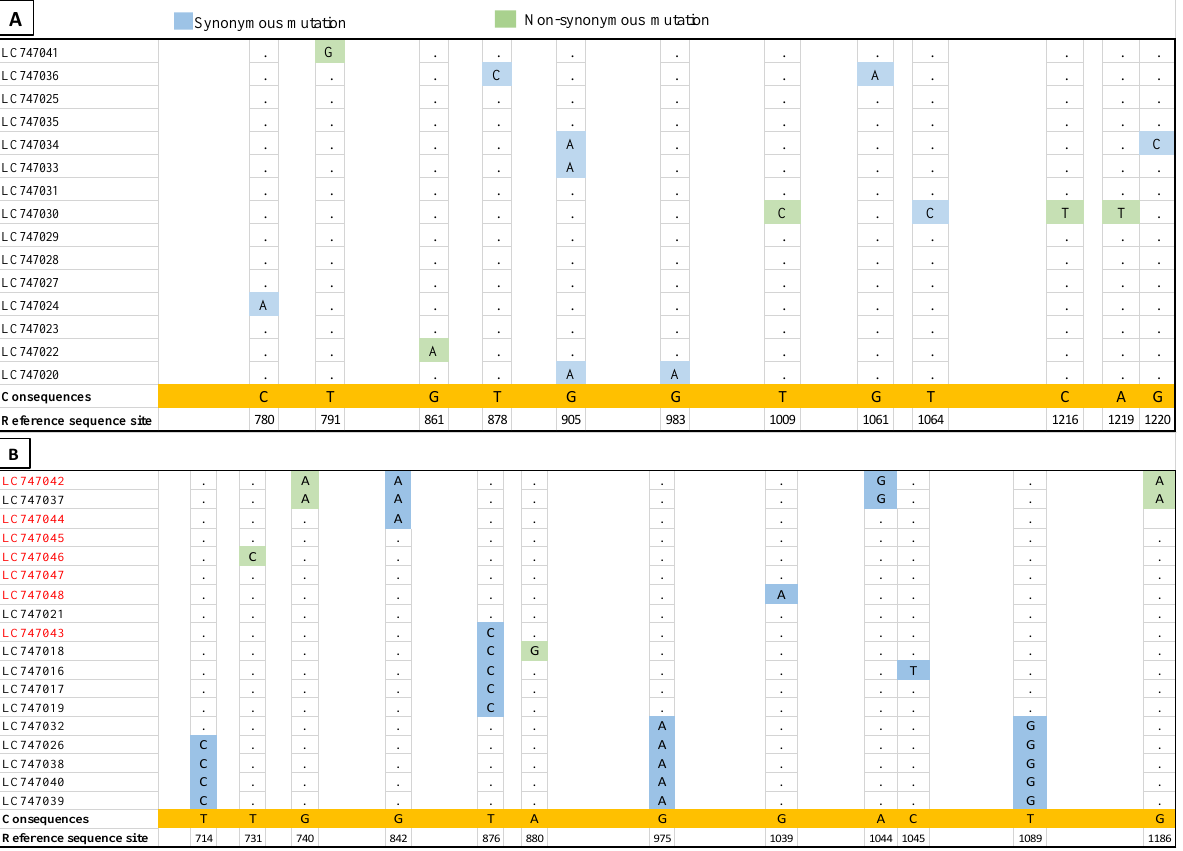
Figure 2. Comparison of the nucleic acid sequence of the SU region. ( A ) Multiple sequence alignment of the SU region for F17/951-Type. ( B ) Multiple sequence alignment of the SU region for FUV-Type. Dots indicate identical consequences. Black and red color labels indicate domestic cat and TLC samples, respectively.